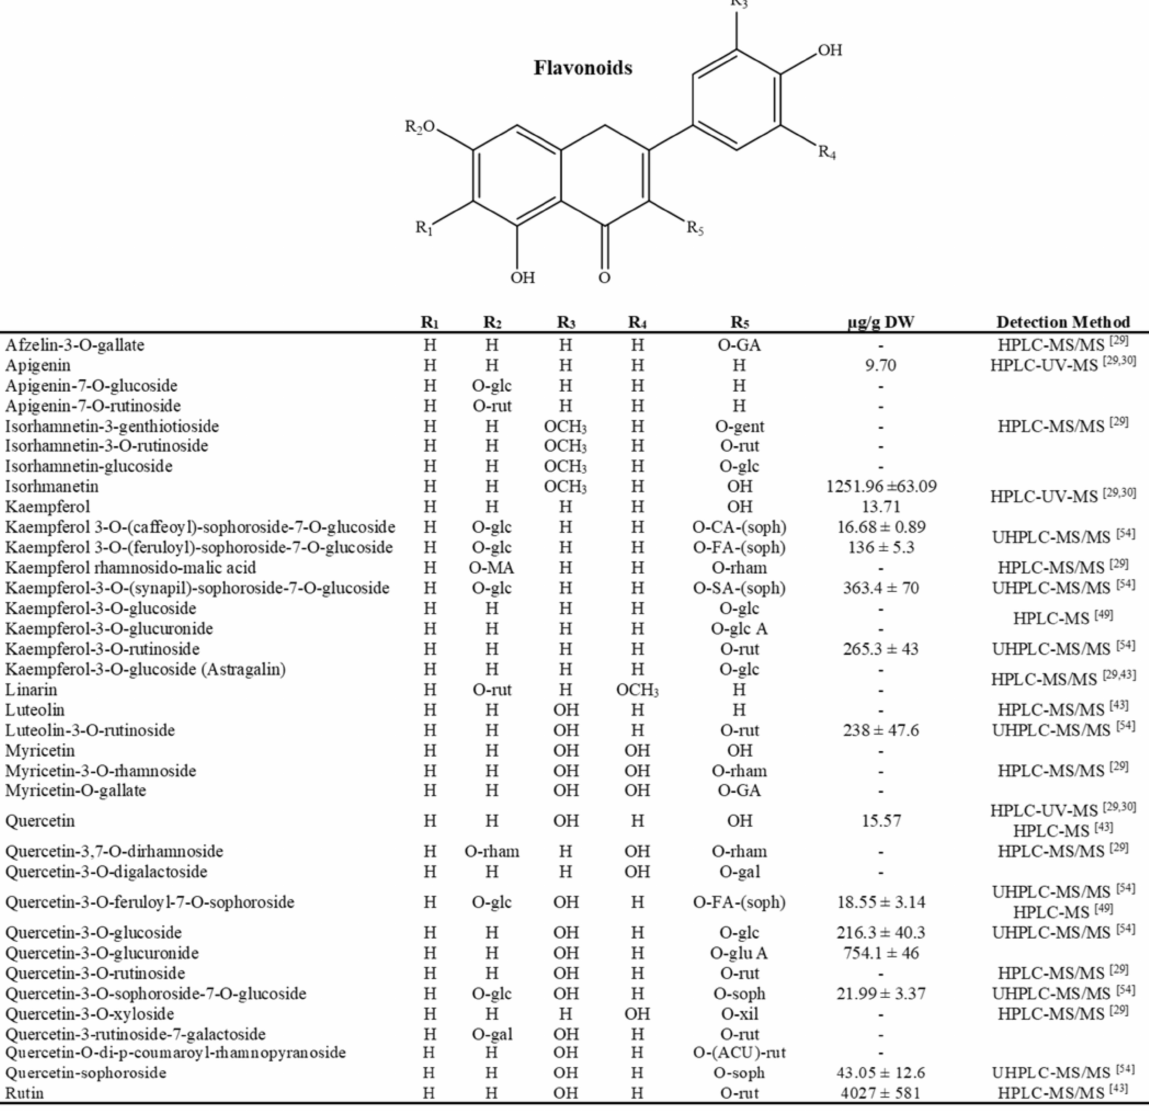
Figure 3. Current flavonoids identified and quantified in the Agave genus, glc = glucose; rut: rutinoside; gal = galactoside; rham = rhamnoside; soph = sophoroside; glu A = glucuronic acid; xil: xyloside; GA = gallic acid; gent = gentrobioside; SA = sinapic acid; FA = ferulic acid, ACU = cumaric acid; MA= mallic acid